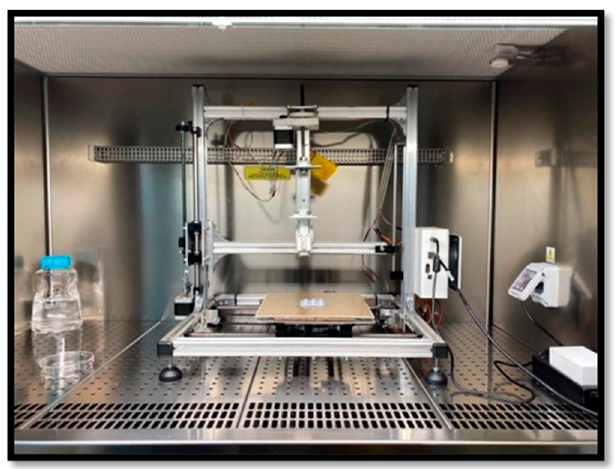
Figure 1. The 3DRAG 3D printer in the safety hood.